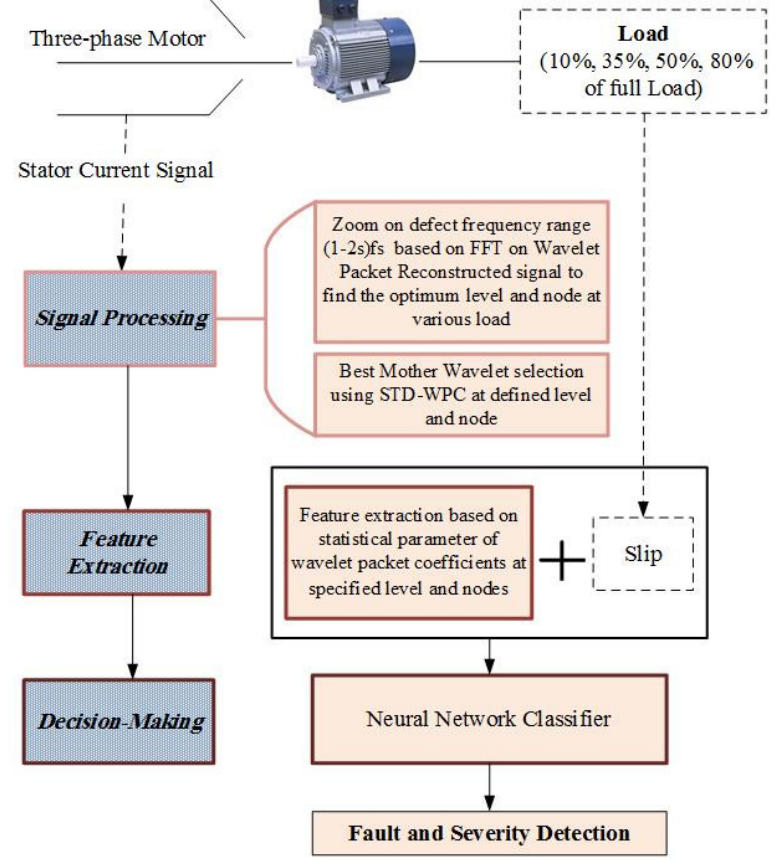
Figure 4. Architecture of the proposed system.